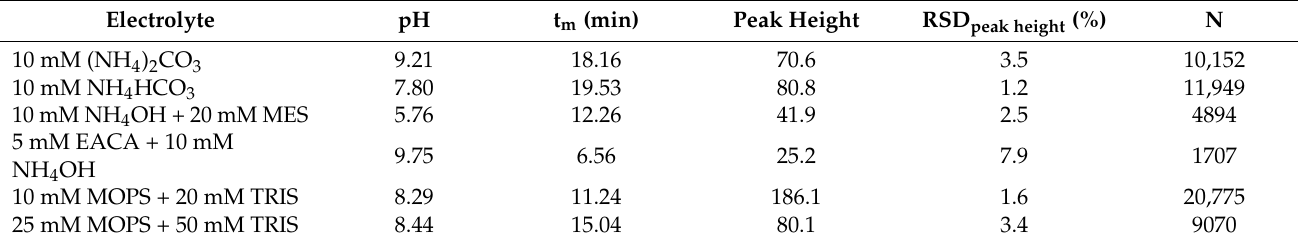
Table 1. Optimization of the BGE